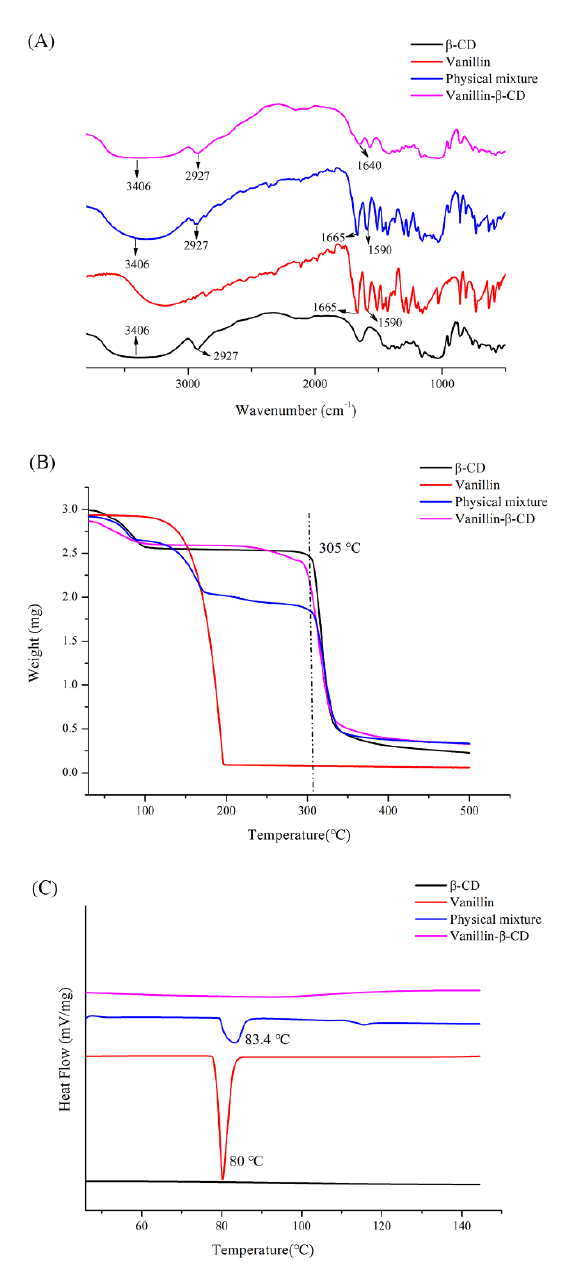
Figure 2. The characterization of vanillin, β -CD, the physical vanillin and β -CD mixture, and the vanillin- β -CD complex by ( A ) FT-IR, ( B ) TGA, and ( C ) DSC.